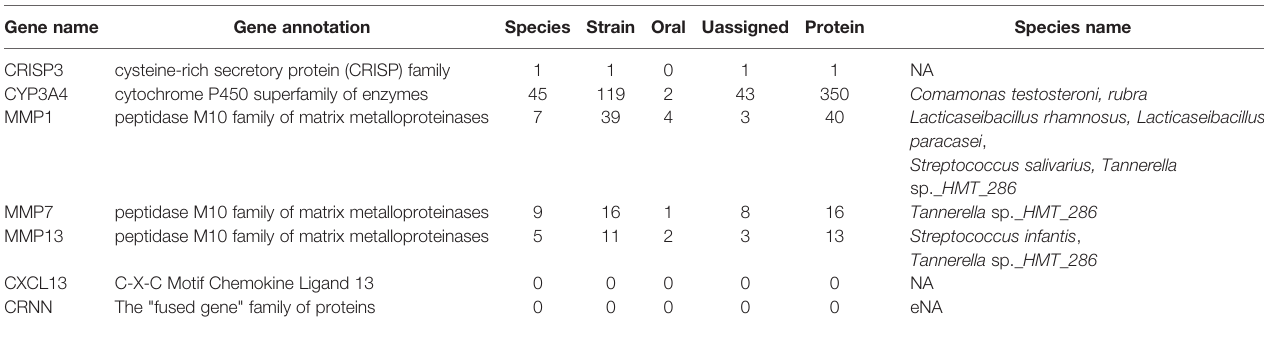
TABLE 1 | The homologous proteins searched of seven DEGs.